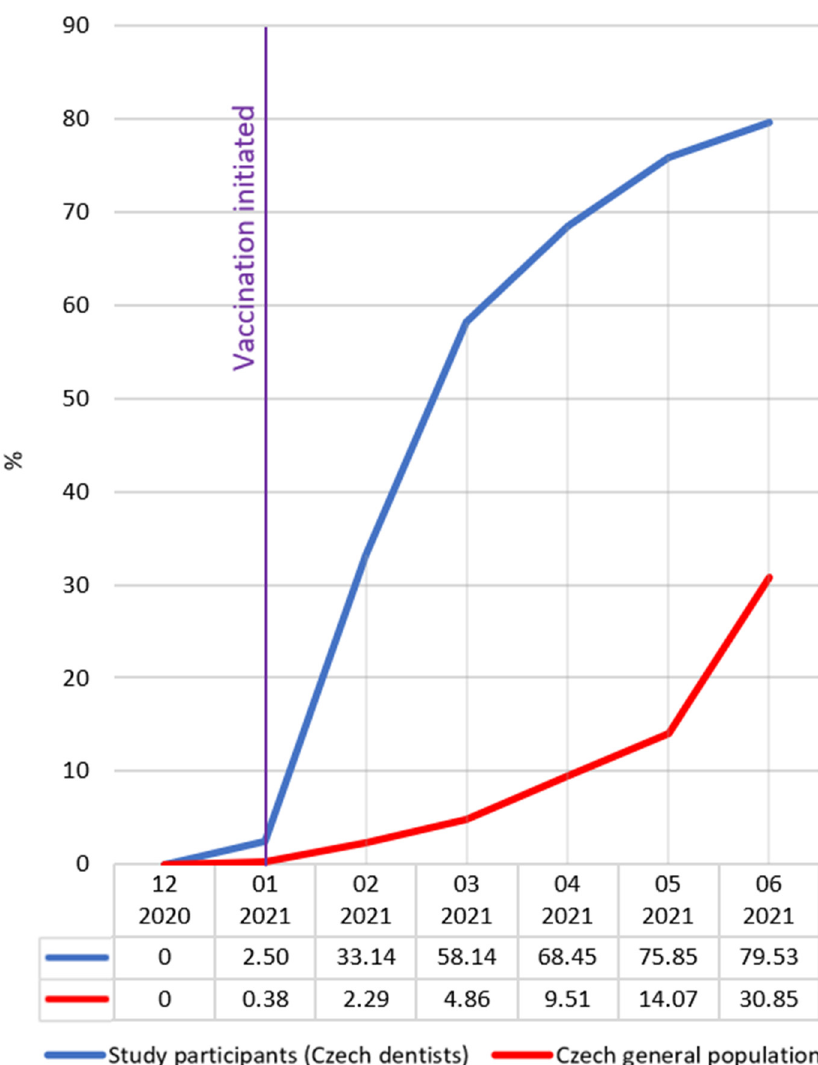
Figure 2. COVID-19 vaccination among Czech dentists and the Czech general population. The purple line indicates the time point when COVID-19 vaccination started.